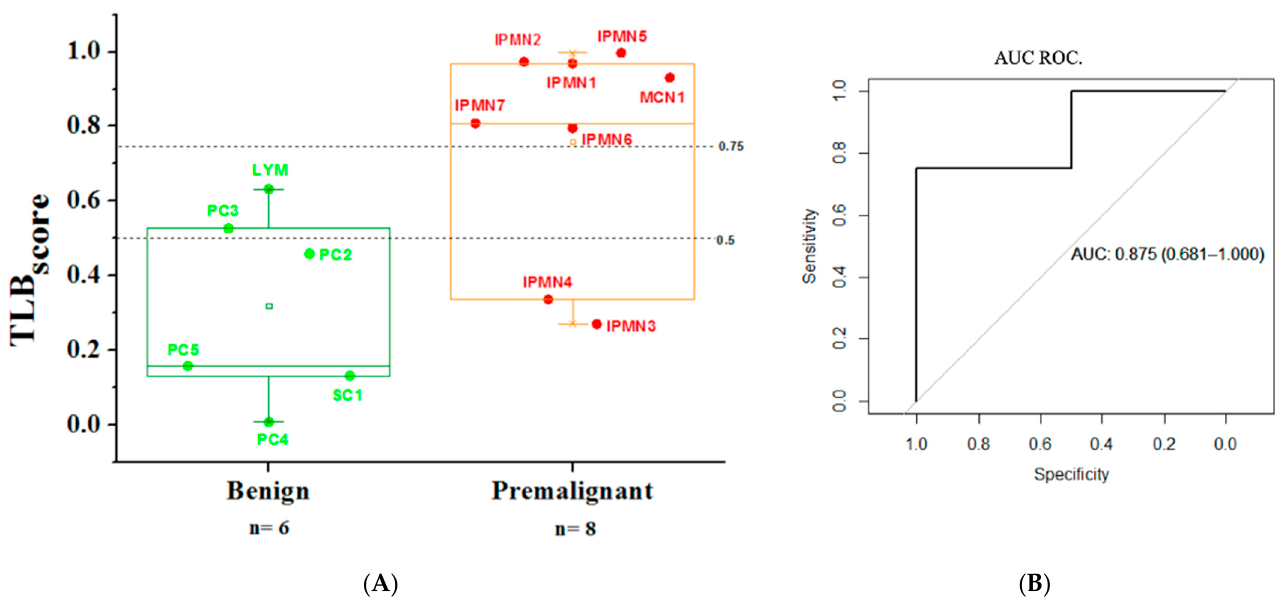
Figure 7. ( A )/TLB serum score parameters from serum TLB serum profiles from benign and premalignant cyst patients. ( B )/ROC curve illustrating the statistical performance of TLB serum score (benign vs. premalignant cysts). AUC = Area Under Curve (95%CI).